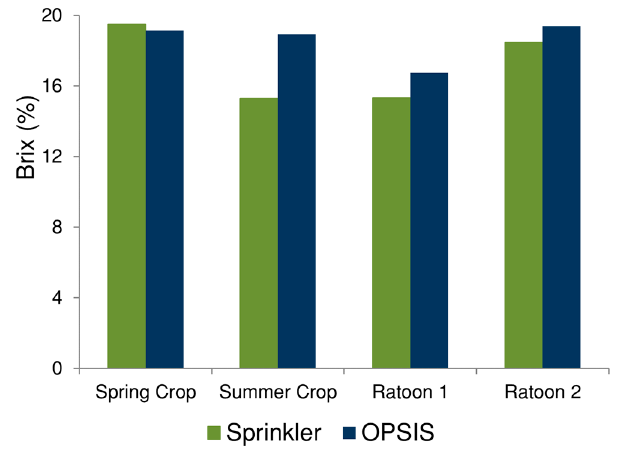
Figure 8. Average Brix value of cane juice of sugarcane cultivar Ni21 as affected by irrigation method.